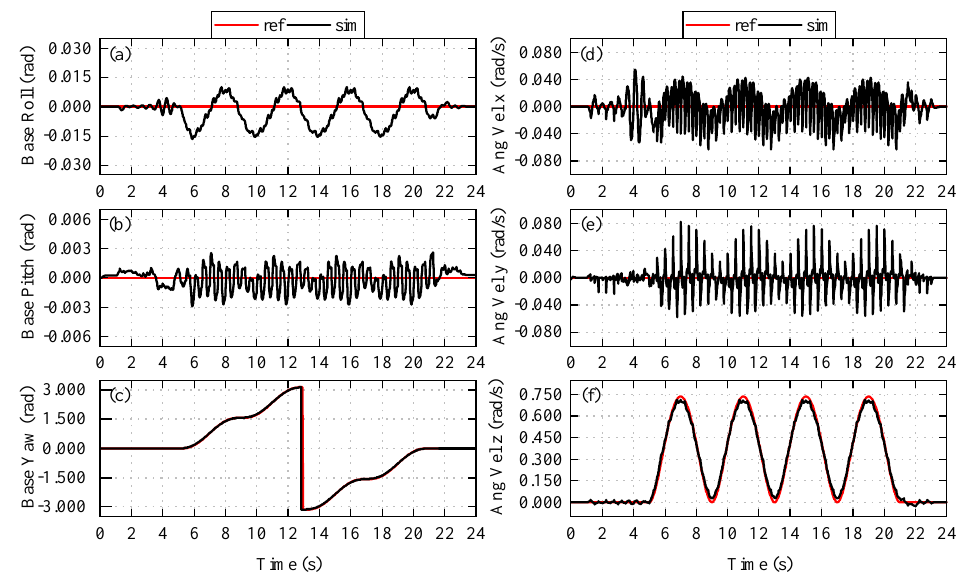
Figure 5. Base orientation and angular velocity. Graphs ( a – c ) are orientation tracking in the x-, y-, and z-direction. Graphs ( d – f ) are angular velocity tracking and these velocities are expressed in the base frame.